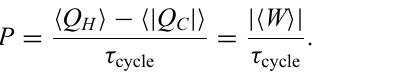
FIG. 4. The evolution of the power output. The blue dots rep- resent the experimental data and the red line is the theoretical prediction based on our spin-exchange model. The green dots and associated numbers give the number of total spin-exchange collisions for a full cycle (collision number 12 is not located at the end of the red line due to numerical errors in calculating the total number of spin-exchange collisions of approximately 1%). The red area marks the positive-temperature regime and the blue denotes negative temperatures, when most atoms are populated in energetically higher states. The gray dashed vertical line indi- cates the theoretical entropy maximum ln ( 7 ) of the system and the solid vertical line the maximum entropy of the engine at